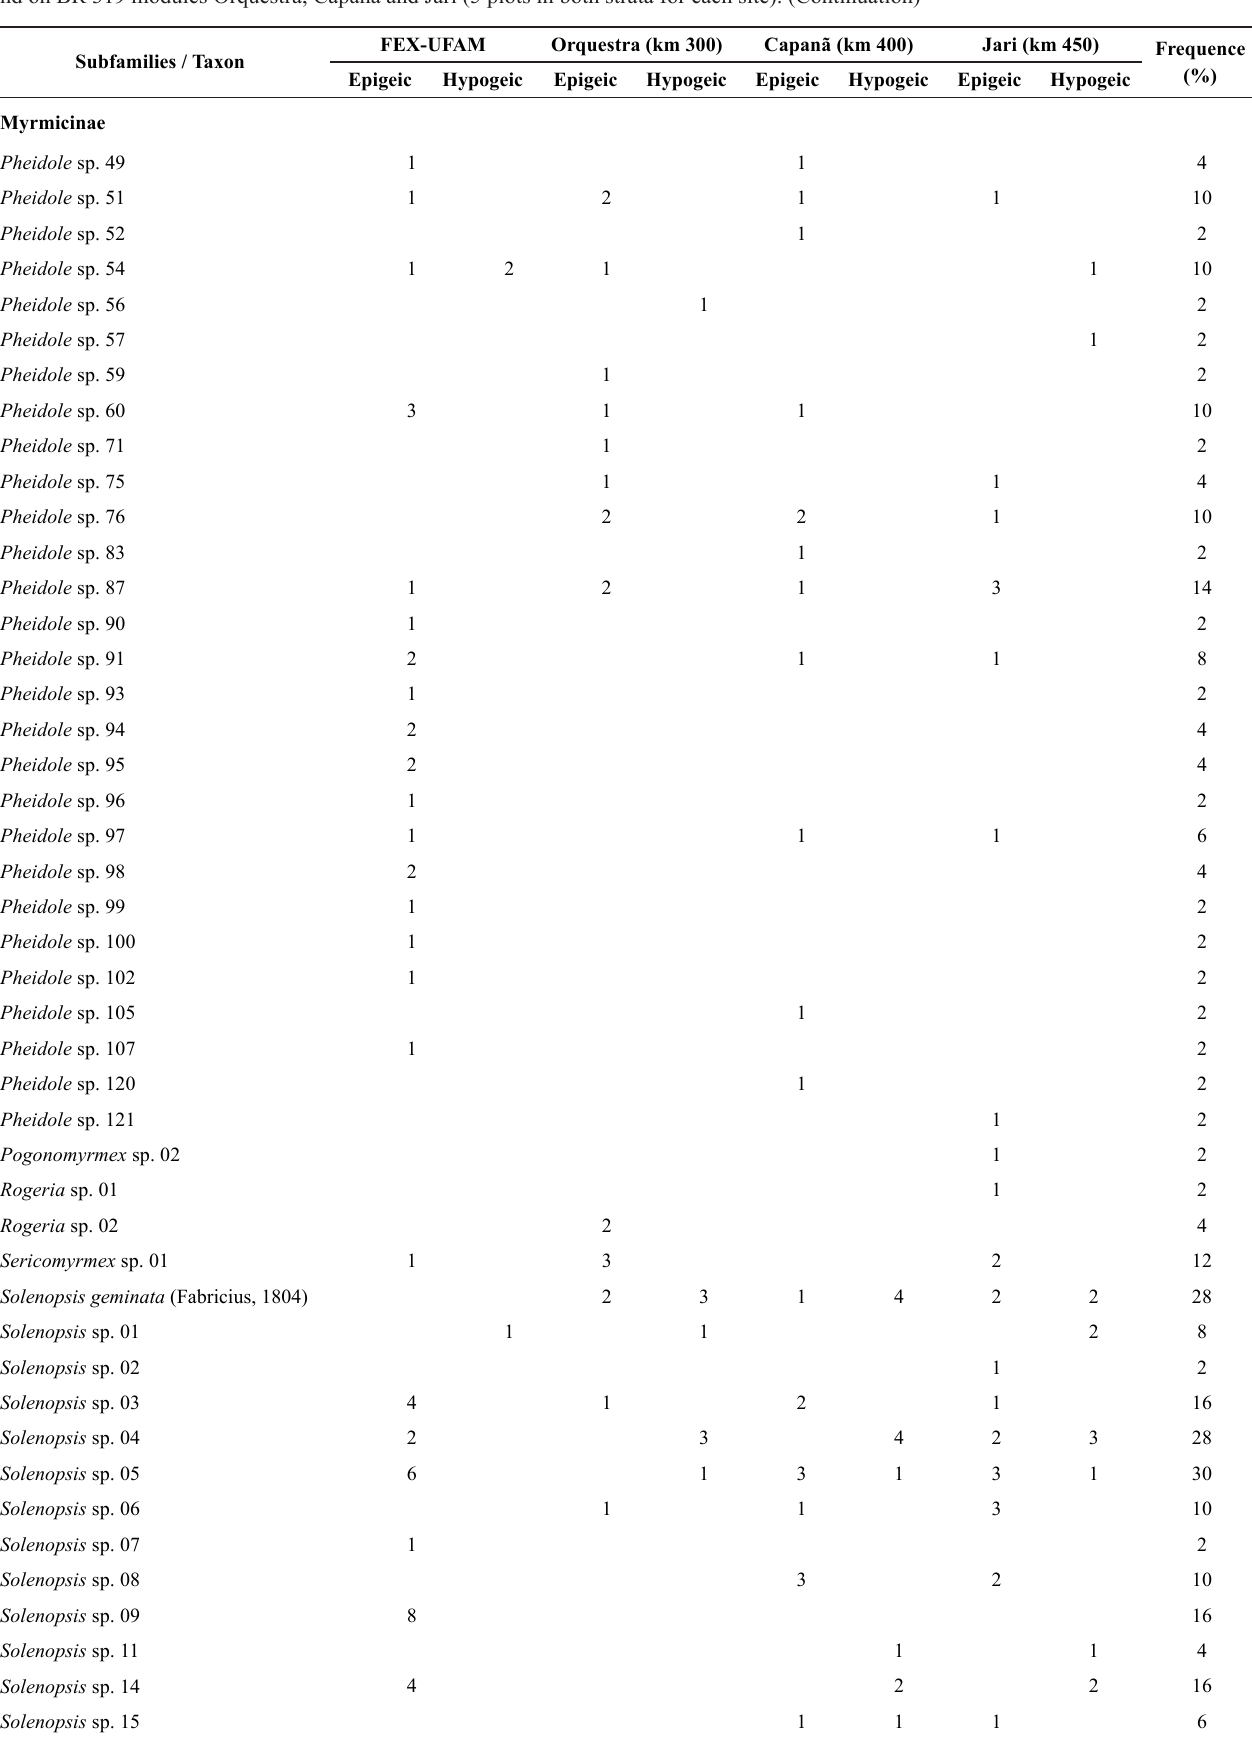
Table 2 . Occurrence and frequency of ant species and morphospecies sampled in the hypogeic (10 plots) and epigeic (7 plots) strata at UFAM and on BR 319 modules Orquestra, Capanã and Jari (5 plots in both strata for each site).